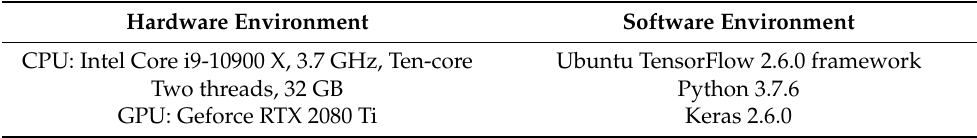
Table 3. Hardware and software